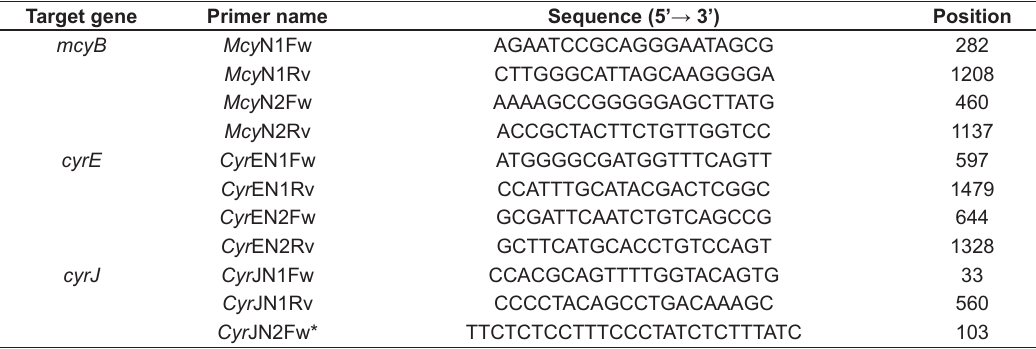
Table 2. Primers designed to amplify mcy B, cyr E, and cyr J by nested PCR. Primers named as N1 were used for the first PCR and N2 for the second round, except for CyrJN1Rv, which was used for PCR1 and 2. The symbol * indicates that the primer was retrieved from Mankiewicz-Boczek, et al. (2012). Primer positions are referred to as the ATG from Microcystis viridis ( mcy ) and Raphidiopsis raciborskii ( cyr ). Target